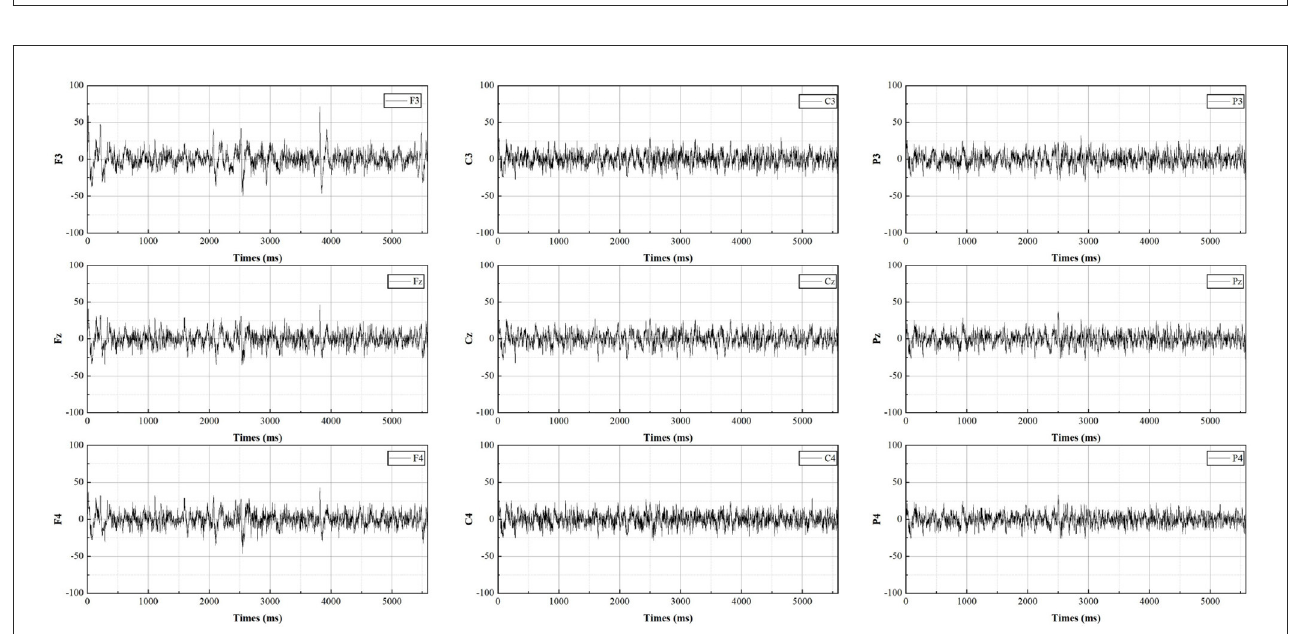
FIGURE7 The average potential value for females during horizontal